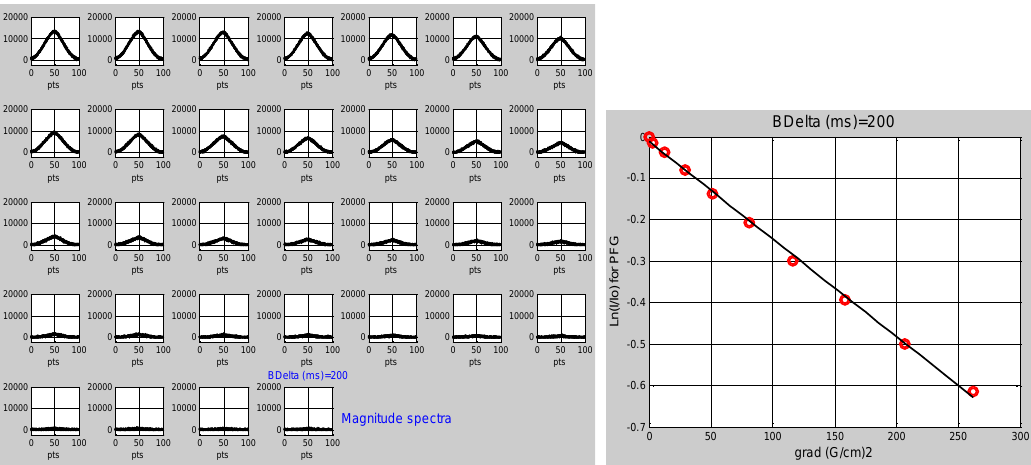
Figure 5. Dependence of echo signals on gradient value in 1D NMR diffusion experiment on spruce piece with water content of 0.8 g H 2 O/g dry matter. MATLAB code was developed (Matrix 7 × 5) to get echo-attenuation value (magnitude with following calculation of integral area) for each gradient step. Wood sample was oriented along X-direction testing for diffusion in tangential direction. The diffusion time Δ = 200 ms. Frequency is 400 MHz, T = 298 K. For left Figure: The intensity (Y-axis) scale is in arbitrary units. X-axis scale is in points.